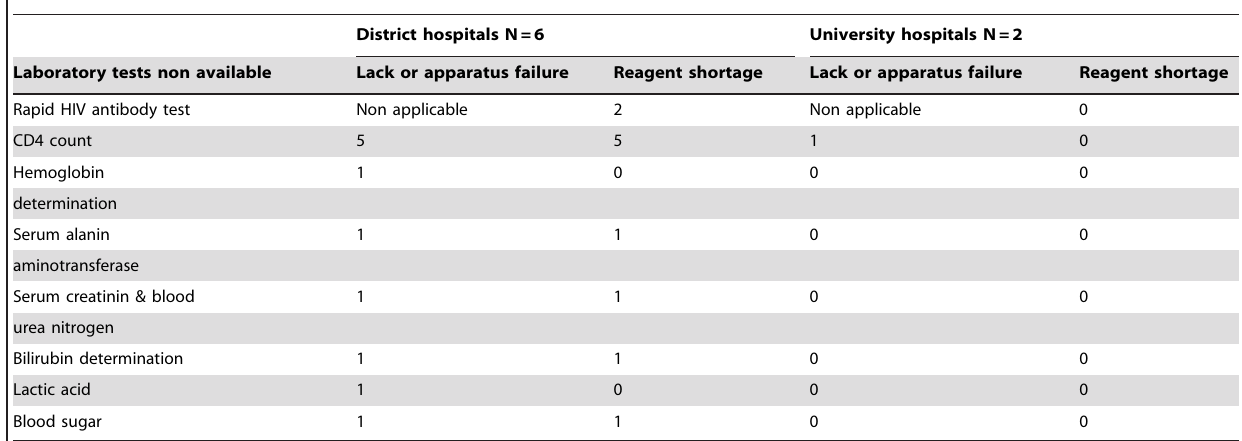
Table 4. Reasons for Ouagadougou laboratory non conformance in